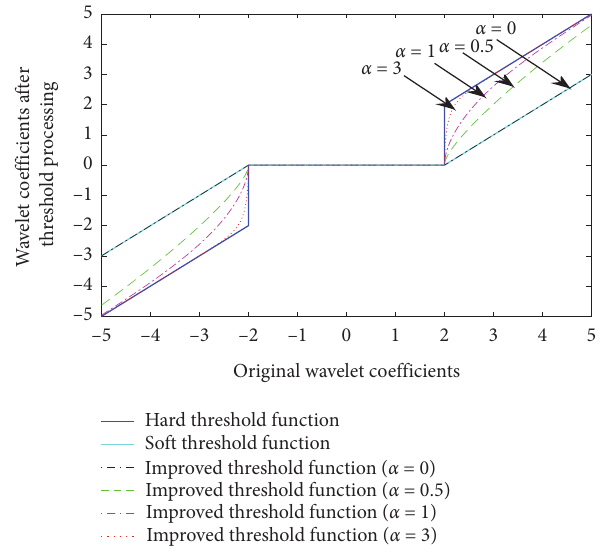
Figure 4: Improved threshold function curves under different values of α